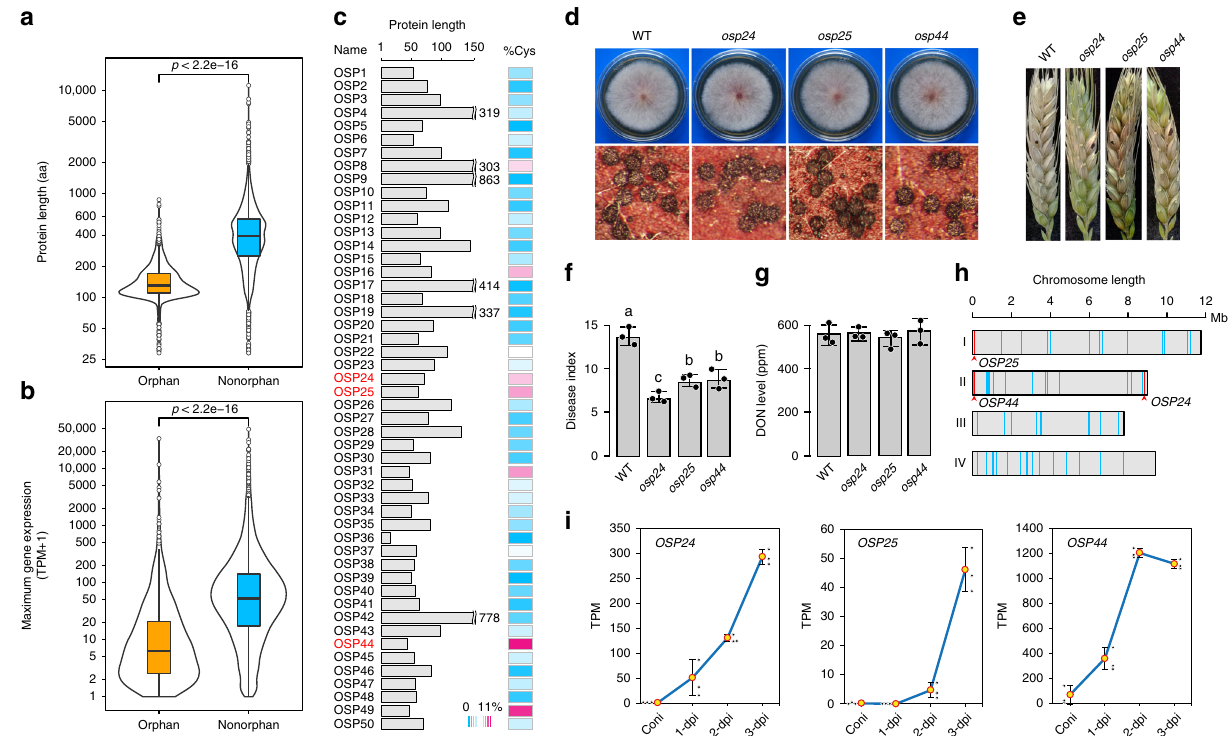
Fig. 1 Characterization of orphan genes encoding secreted proteins in Fusarium graminearum . a Comparative analysis of the length of proteins encoded by orphan and non-orphan genes with the Wilcoxon rank-sum test ( p < 2.2e − 16). b Comparative analysis of the expression levels of orphan and non- orphan genes with the Wilcoxon rank-sum test ( p < 2.2e − 16). For each gene, the maximum gene expression level was estimated from its transcripts per kilobase million (TPM) in RNA-seq data of conidia, vegetative hyphae, perithecia, and infected wheat heads. c Length and Cys (cysteine) content (%) of mature orphan secretory proteins (OSPs). The three OSPs important for virulence are in red. d Representative images of 3-day-old PDA cultures and 8-dpf (8 days post-fertilization) mating plates of the wild-type strain PH-1 (WT) and the osp24, osp25 , and osp44 deletion mutants. e Representative images of wheat heads infected with marked strains were photographed at 14 dpi. f The disease index of WT and three osp mutants. Error bar represents standard deviation (SD) from mean (marked with black dots on the bars) of three independent experiments ( n = 3) with at least 10 wheat heads examined in each experiment. Different letters indicate signi fi cant differences based on ANOVA analysis followed by Duncan ’ s multiple range test ( P = 0.05). g Mean and standard deviations of DON levels in diseased wheat spikelets inoculated with WT or three osp mutants based on data from three biological replicates ( n = 3). No signi fi cant differences was observed based on ANOVA analysis followed by Duncan ’ s multiple range test ( P = 0.05). h Distribution of the OSP genes (blue vertical bars) on the four chromosomes of F. graminearum . Red bars and arrowheads indicate the positions of OSP24, OSP25 , and OSP44 . i Expression levels of the indicated OSP genes based on their TPMs in RNA-seq data of conidia and infected wheat heads 20 sampled at 1-dpi, 2-dpi, or 3-dpi. Error bar represents SD from three biological replicates ( n =